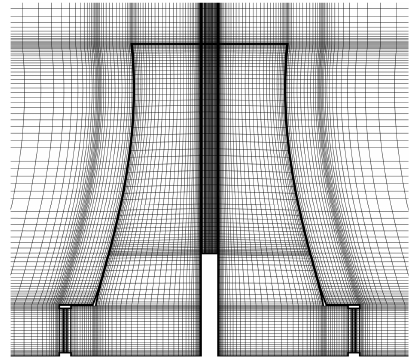
Figure 4. Schematic of mesh for the NDDCT with flue gas injection.